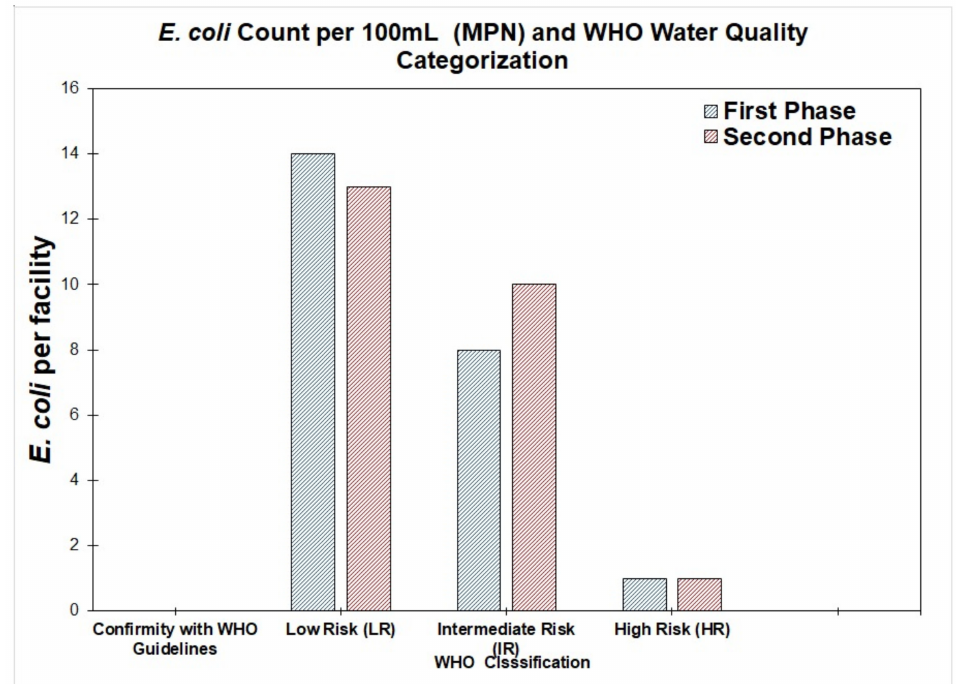
Figure 3. E. coli count per 100 mL according to the WHO standard E. coli classification for the first and second phase sample